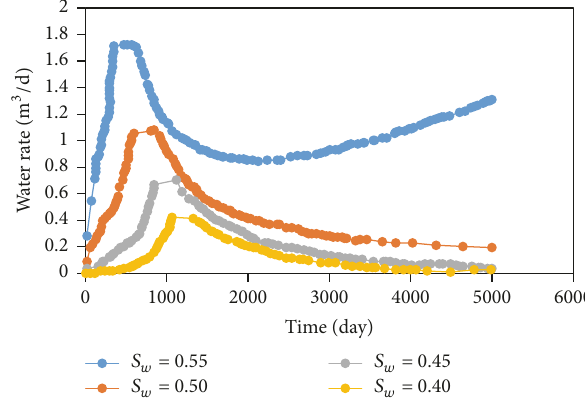
Figure 17: Effect of water saturation on water production.